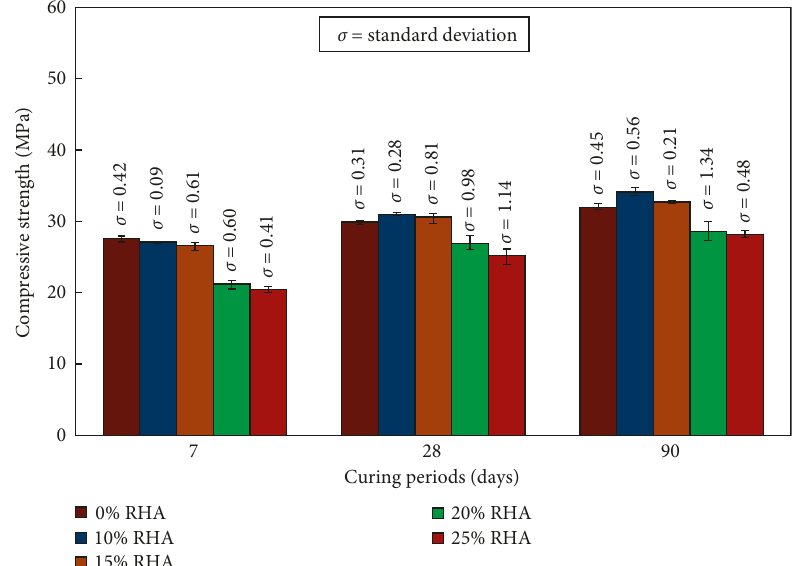
Figure 4: Compressive strength of RBAC after 7, 28, and 90 days of curing.